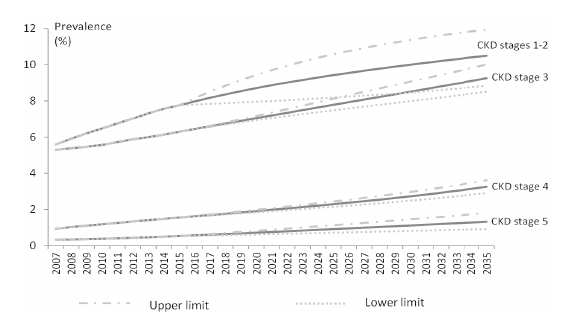
Figure 2: Prevalence of CKD by stage, with projection till 2035.